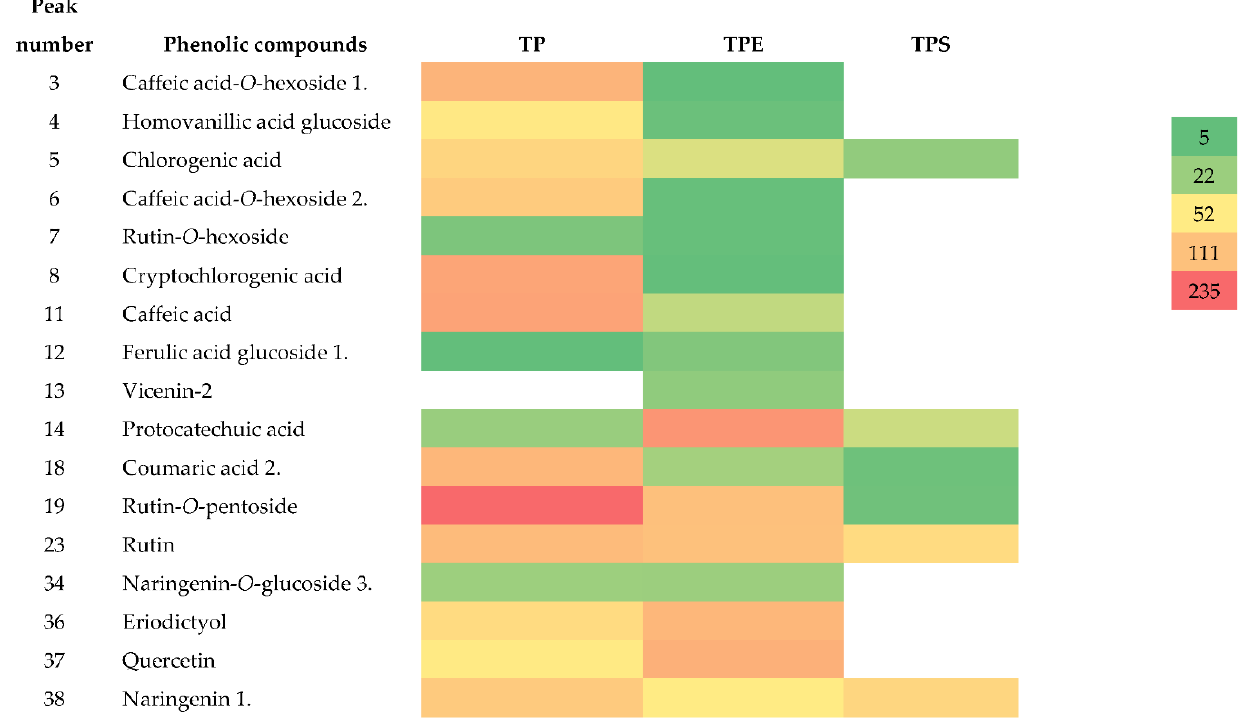
Figure 1. Heatmap representing the results of semi-quantitative comparison of individual phenolic compound identified in the tomato pomace containing seeds (TP), tomato protein (TPE), and tomato skins and peels (TPS). The relative abundances (relative intensity) detected by the mass spectrometer are shown with different colors. The deeper is the red color, the higher is the relative mass abundance of the phenolic compound; the deeper is the green color, the lower is the relative mass abundance of the phenolic compound. Calculations were performed based on areas of MS extracted ion chromatogram (EICs). The data normalization was performed including the correction for dilution during sample preparation.